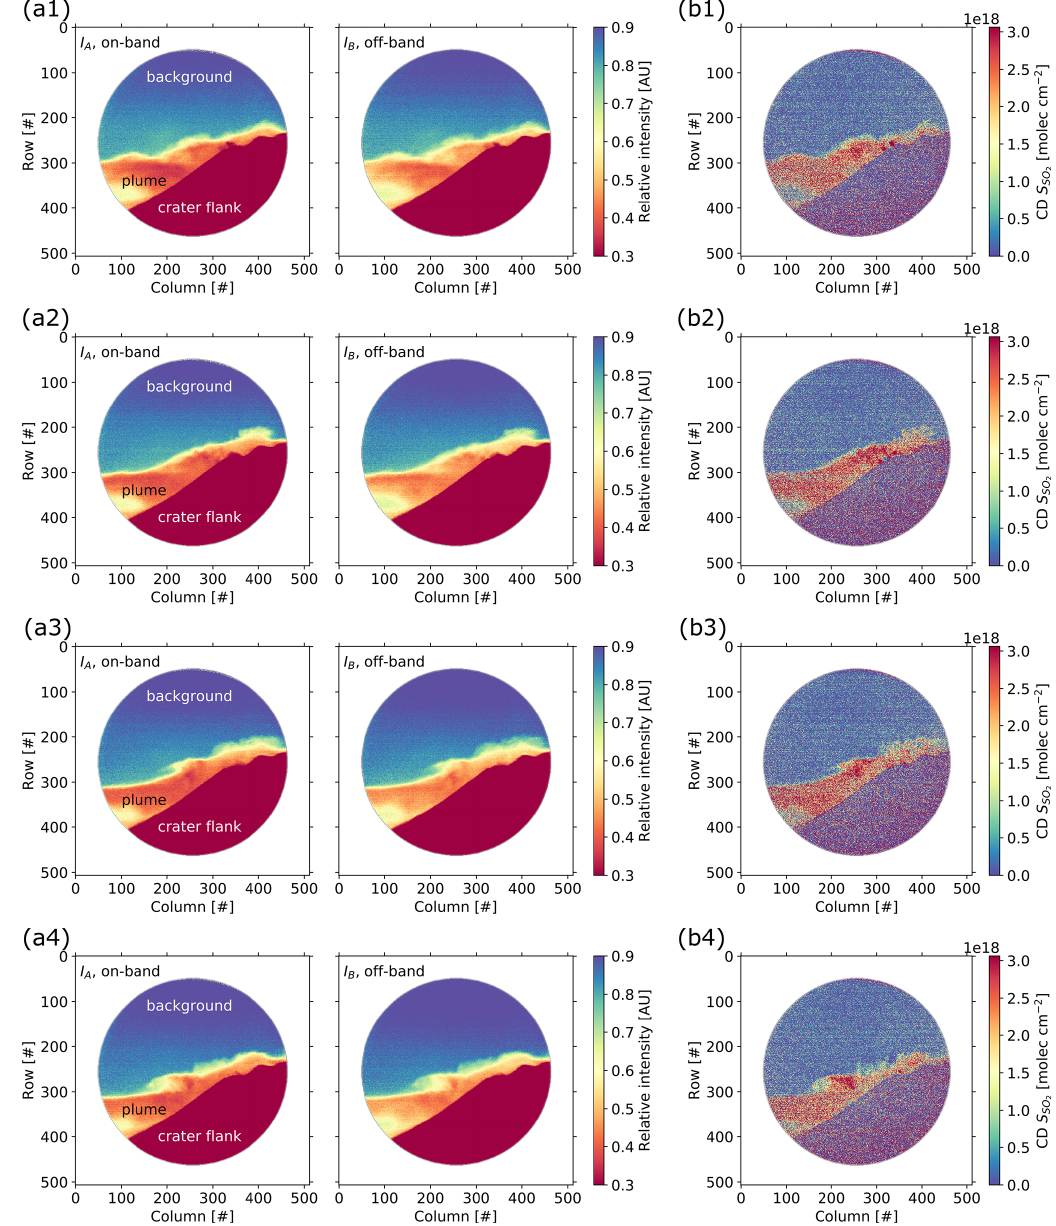
Figure A1. Exemplary set of evaluated images (400 × 400 pixels) acquired with the IFPICS prototype on 22 July 2019 at 08:50–09:10CET at Mt. Etna, Italy. The time difference between each set of images (1–4) accounts for ≈ 120s, allowing us to trace back plume dynamics. (a) Flat-field-corrected intensity images I A and I B . (b) Volcanic plume SO 2 CD S SO shown in Eq.